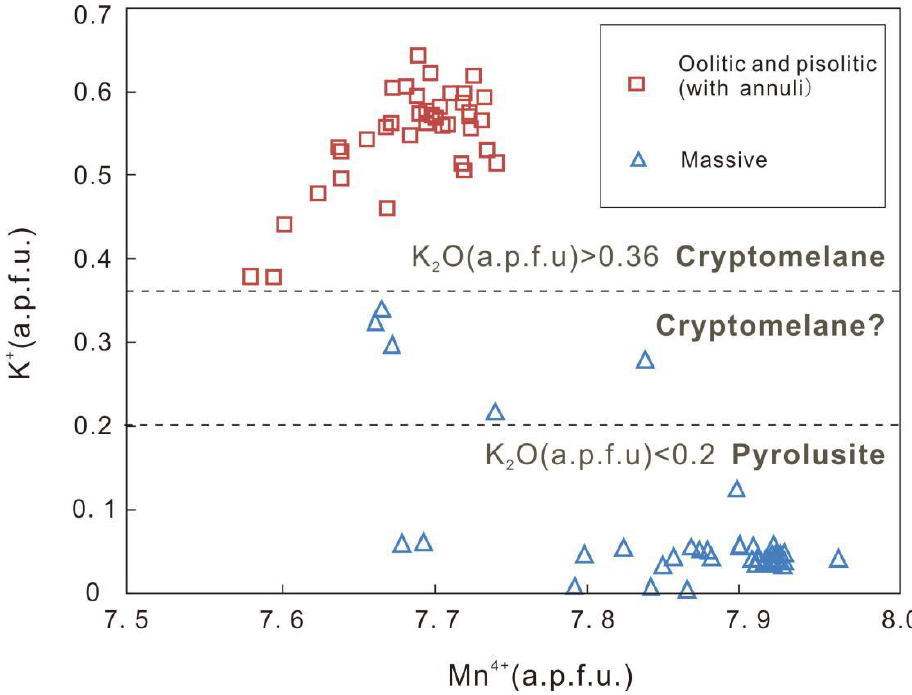
Figure 7. Mn 4+ vs. K + for cryptomelane and pyrolusite.